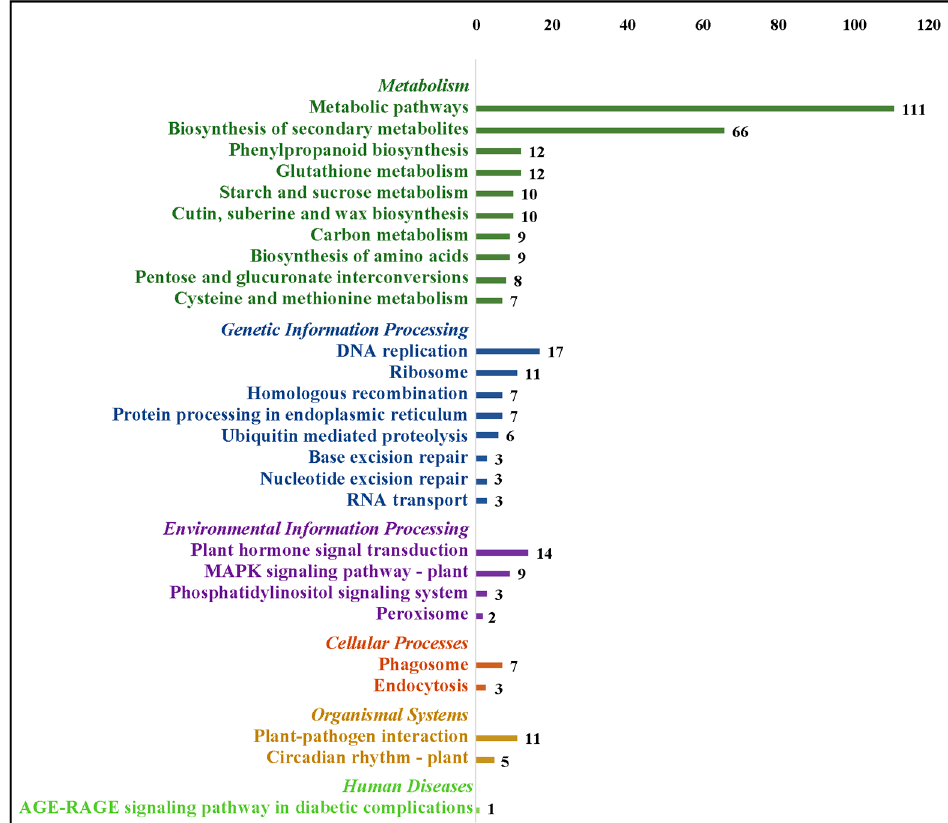
Figure 10. KEGG function analysis of common differentially expressed genes. Only top 10 pathway terms are displayed in each group.